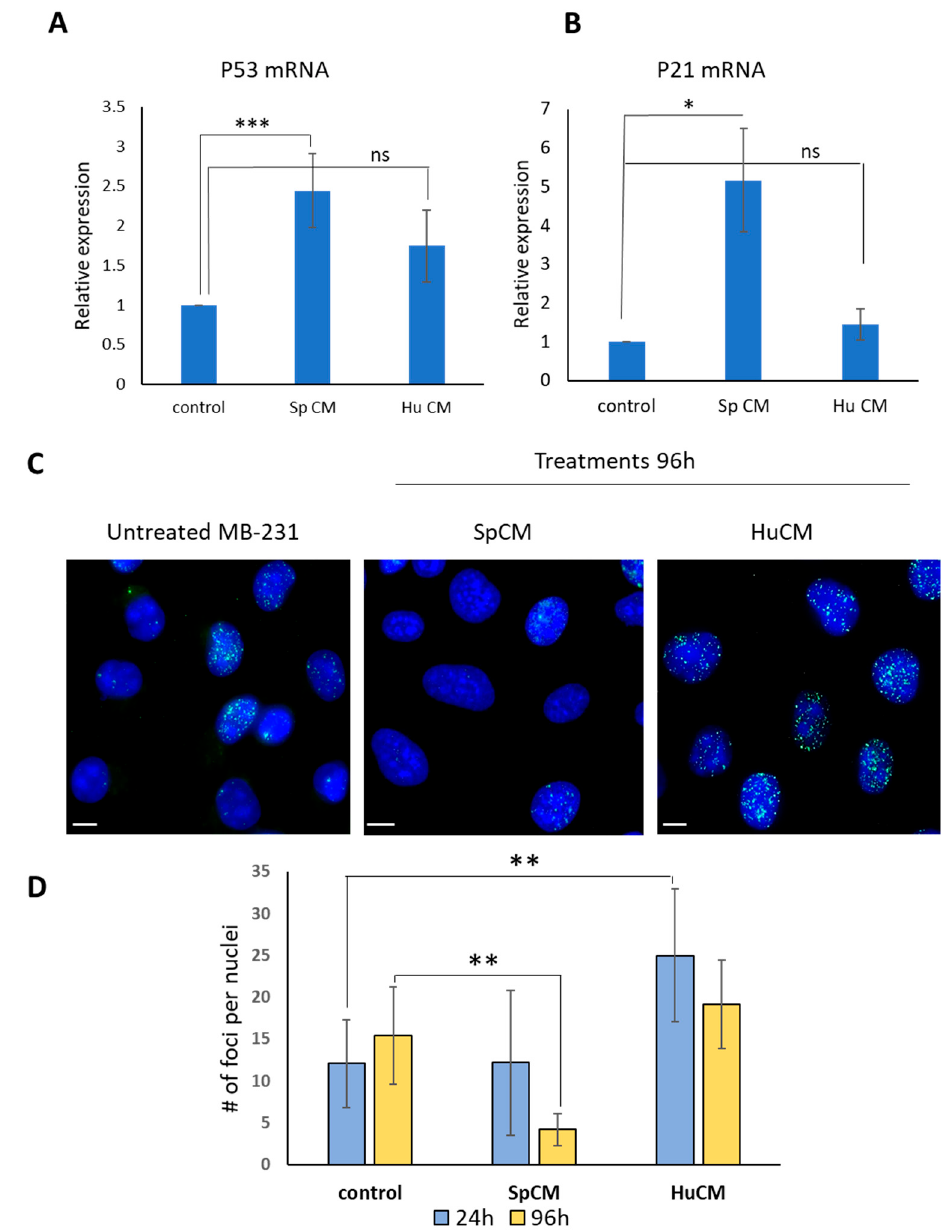
Figure 2. Effects of Spalax and human CMs on p53/p21 senescence markers and on the spontaneous DSBs in MDA-MB231 cells. ( A , B ) p21 and p53 mRNA levels were quantified in MDA-MB231 under exposure to Spalax (Sp)/human (Hu) CMs by using relative qRT-PCR;. Experiments were performed in triplicates and repeated 3 times. Data are presented as mean ± SE * p ≤ 0.05; *** p ≤ 0.001, differences between treated MDA-MB-231 cells vs. untreated; “ns”, not significant p value. ( C ) MDA-MB231cells were treated with Spalax and human CM for 24- or 96 h; thereafter, cells were fixed and stained with anti- γ -H2AX antibody and counterstained with DAPI. Representative images of γ -H2AX (pSer13) foci in the nuclei of MDA-MB-231 untreated and treated for 96 h are shown. Bars, 10 μ m. ( D ) The images were used for quantification using FociCounter software (minimum 250 nuclei per sample were analyzed). Data is presented as mean ± SD of three independent experiments (n = 3), ** p ≤ 0.01 differences between treated MDA-MB-231 with Spalax CM and control at 96 h. ** p ≤ 0.01 differences between treated MDA-MB-231 with human CM and control at 24 h. # means the number